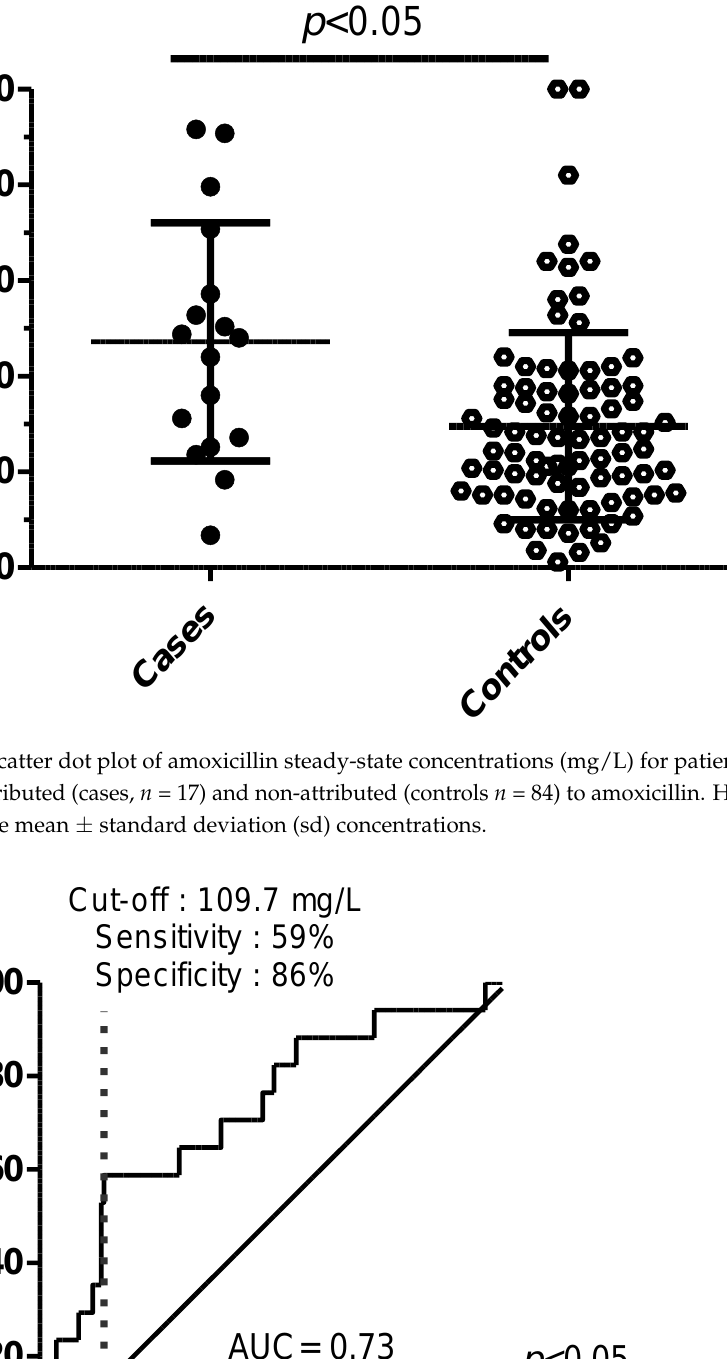
Figure 1. ( a ) Distribution of amoxicillin median daily dose (g), ( n = 86); ( b ) distribution of estimated glomerular filtration rate (mL/min), ( n = 101) for patients with neurotoxicity attributed (cases) and non-attributed (controls) to amoxicillin. Horizontal solid lines are the median.